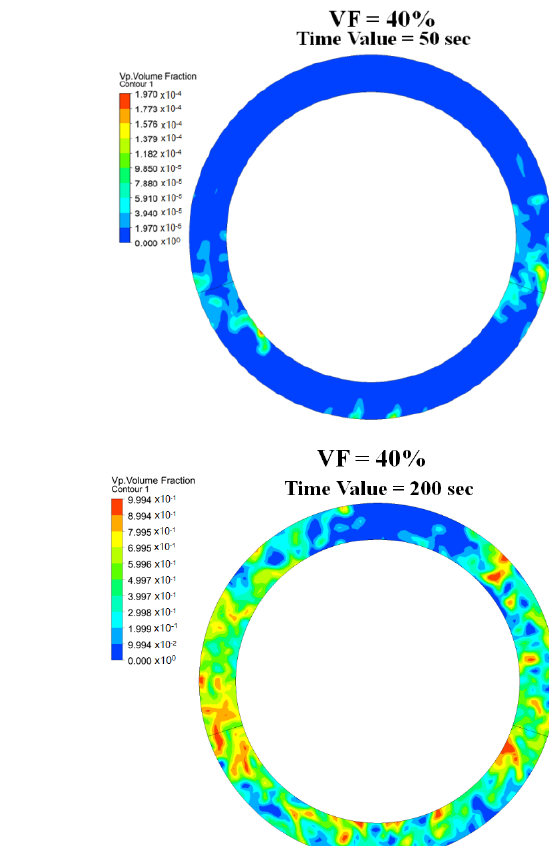
Figure 12. Comparison of effect of different D + values.